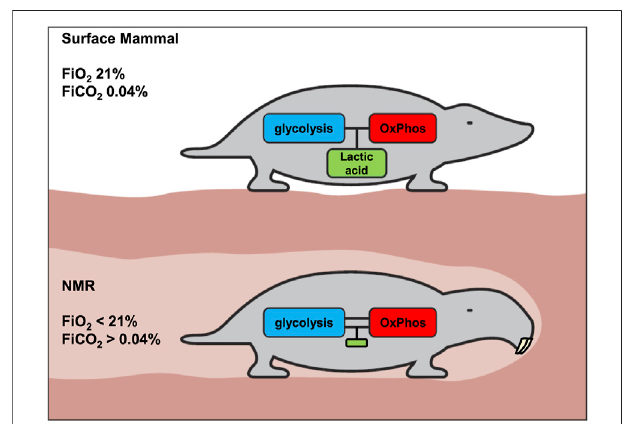
FIGURE 4 | Proposed metabolic difference between surface mammals and NMRs with respect to coupling of glycolysis and OxPhos. The generation of lactic acid allows tissues to more fl exibly generate ATP. A consequence of this fl exibility is transient regional or systemic acidosis. We hypothesize that acidosis is strongly inhibited in the NMR, and that consequently the coupling of glycolysis and OxPhos must be much stronger in NMRs, to avoid undesired pH-decreases. Accordingly, it is proposed that, compared to above-ground mammals, the NMR will display less acidosis and lower lactate levels under various stress